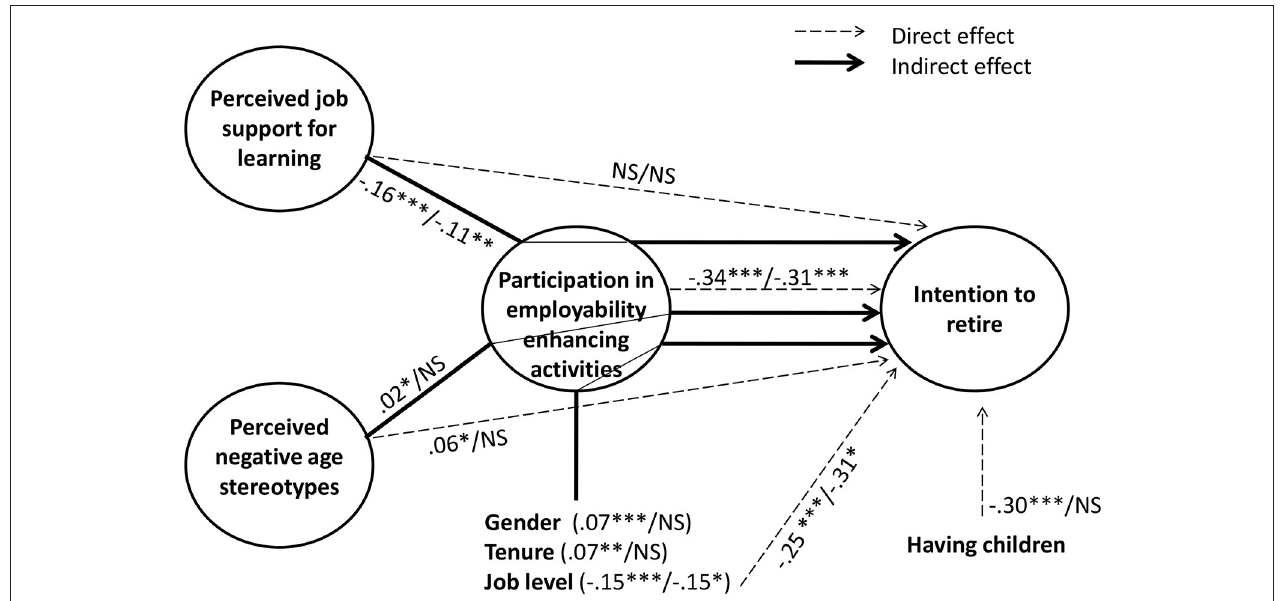
FIGURE 1 | Parameter estimates of the Multi-Group SEM (Standard coefficients). The coefficients of the different employees age groups are sorted in ascending order: 55–60 years old/61–65 years old. *** p < 0.001; ** p < 0.01; * p <